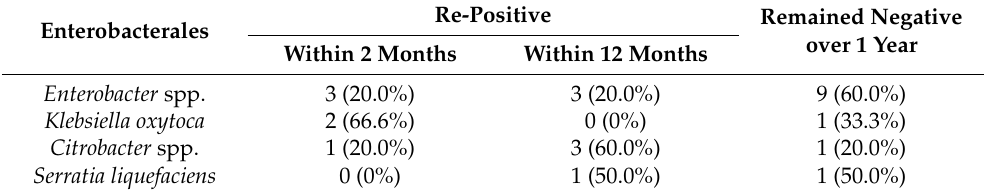
Table 2. Duration required by the bacterial species to recontaminate the hospital sink outlets. Re-Positive Remained Negative Enterobacterales over 1 Year Within 2 Months Within 12 Months Enterobacter spp. 3 (20.0%) 3 (20.0%) 9 (60.0%) Klebsiella oxytoca 2 (66.6%) 0 (0%) 1 (33.3%) Citrobacter spp. 1 (20.0%) 3 (60.0%) 1 (20.0%) Serratia liquefaciens 0 (0%) 1 (50.0%) 1